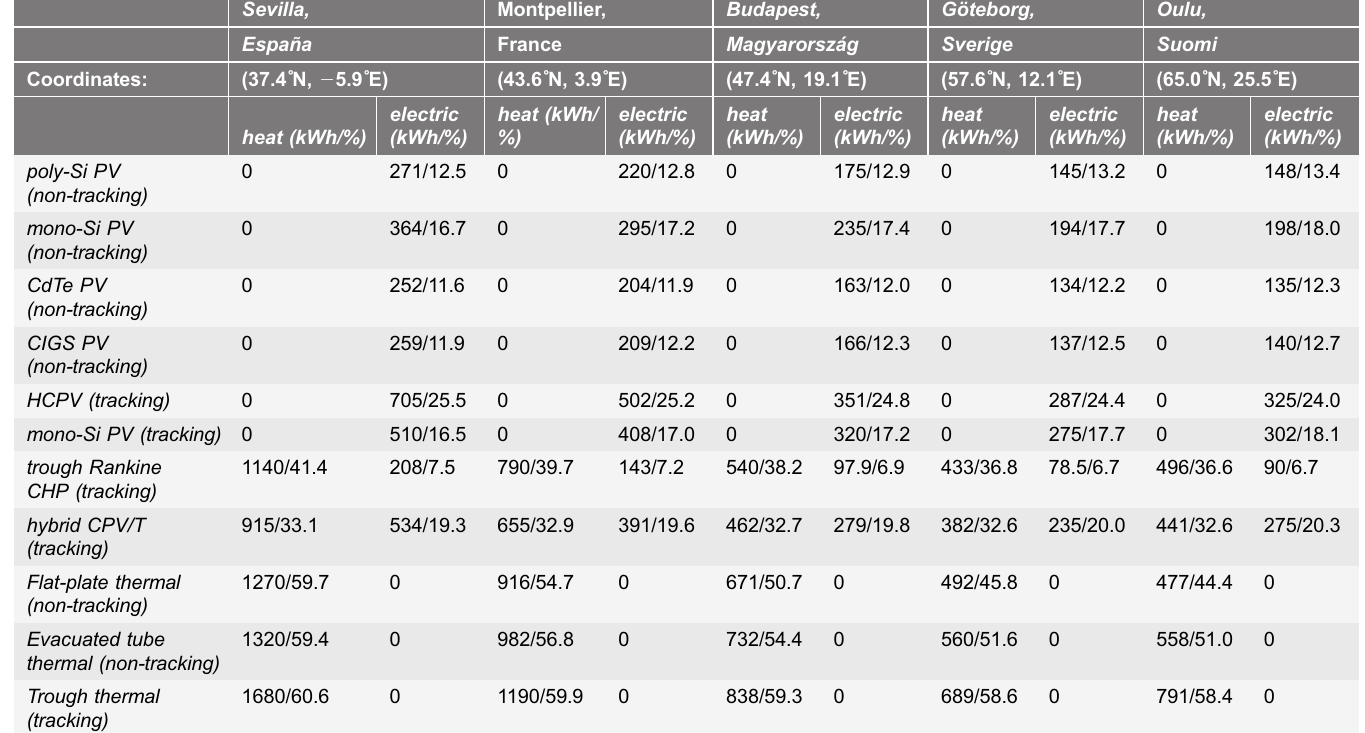
Table 5. Annual electricity and heat production and respective efficiencies (as a percent of total absorbed irradiance) of various solar technologies near several European